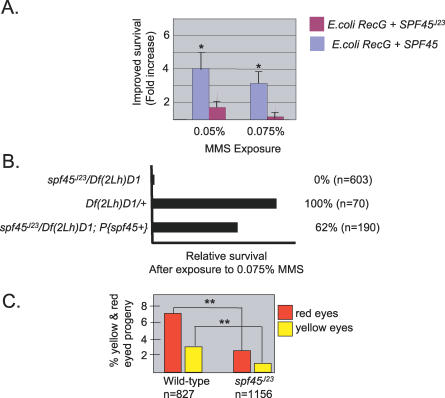
SPF45 Function Is Required to Repair DNA Damage(A) Ectopic expression of SPF45 improves the survival rate of E. coli recG mutants after MMS exposure. The survival was expressed as the average-fold increase in survival over the control E. coli recG mutants. Error bars are standard deviations calculated from five independent experiments. An unpaired t test was performed to assess whether there is a statistically significant difference between survival rates of an E. coli recG strain expressing a D. melanogaster protein (either SPF45J23 or SPF45+) and the survival rate of the same E. coli recG strain expressing an empty GST vector. Asterisks denote differences significant at the 95% level (p < 0.04).(B) spf45 animals have an MMS-sensitive mutant phenotype. Survival was assessed by comparing the number of mutant animals that survived to adulthood with the number of control siblings (spf45J23/CyO or Df(2Lh)D1/CyO) recovered from the same cross.(C) Damage after P-element excision is not repaired efficiently in an spf45 mutant background. Eye colors of female progeny that inherited the repaired P{wa} were scored. The total number of females scored is indicated below the relevant genotype. A chi square test was performed to assess whether there is a significant difference between the frequency of repair events. Asterisks denote differences significant at the 99.9% level (p < 0.0005).